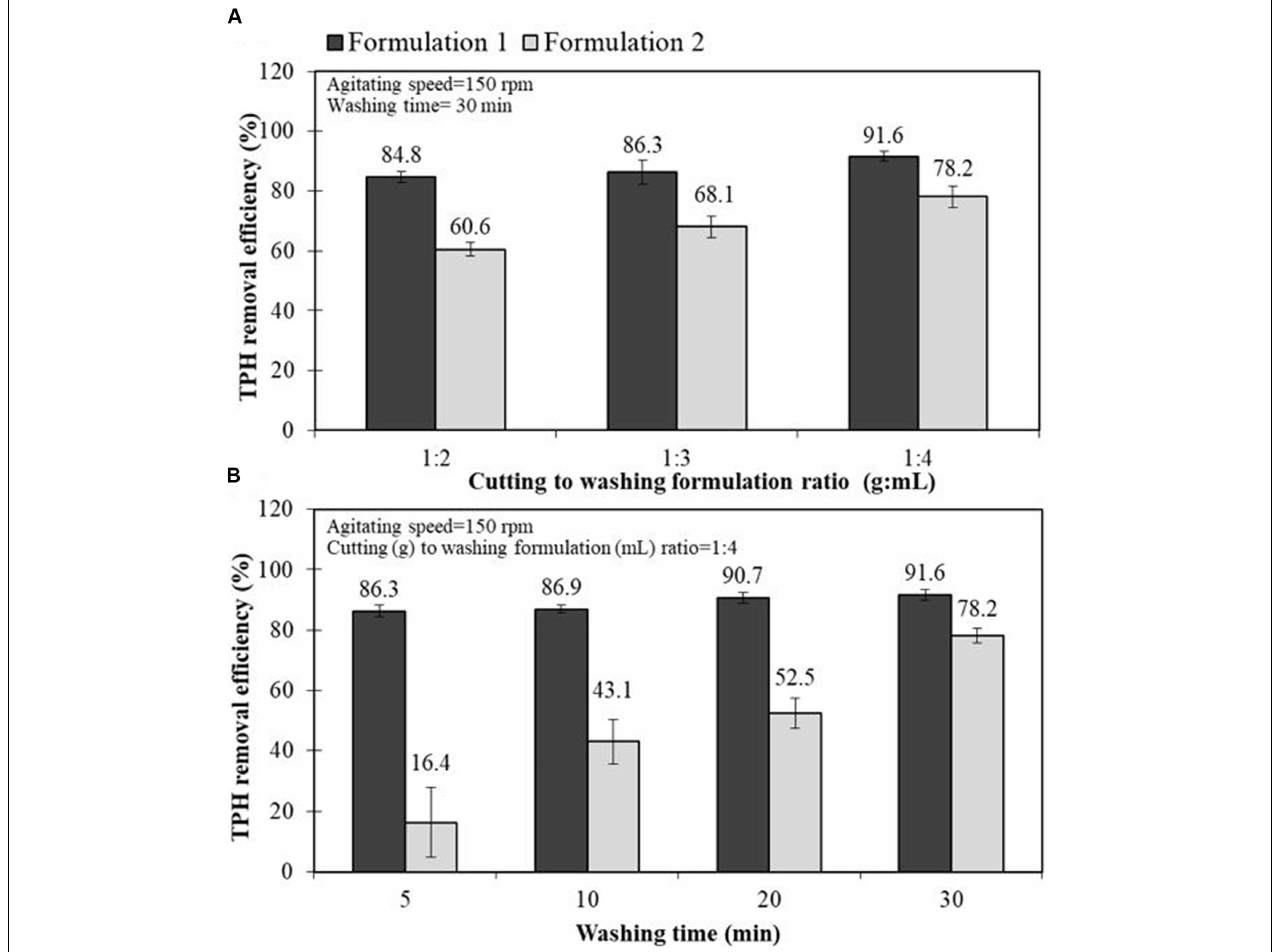
FIGURE 3 | Effect of drill cutting-to-washing agent ratio (A) and washing time (B) on the petroleum hydrocarbon removal efficiency of the bio-based washing formulations, F1 (20% Foamate + 2% Dehydol LS7TH + 78% DI) and F2 (20% Foamate + 2% Dehydol LS7TH + 4% Butanol + 74% saline water) in a jar test